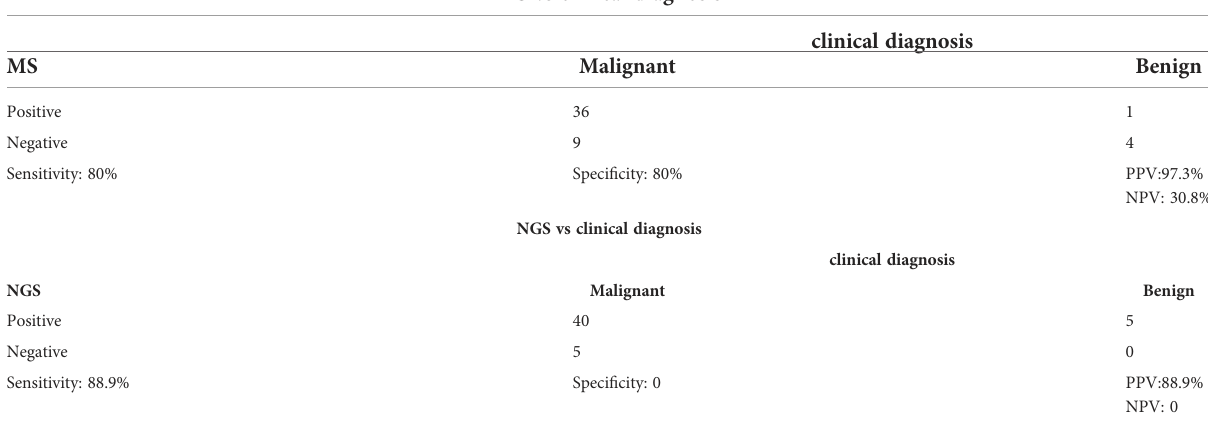
TABLE 4 Relationship between the NGS or MS detection results and clinical diagnosis.